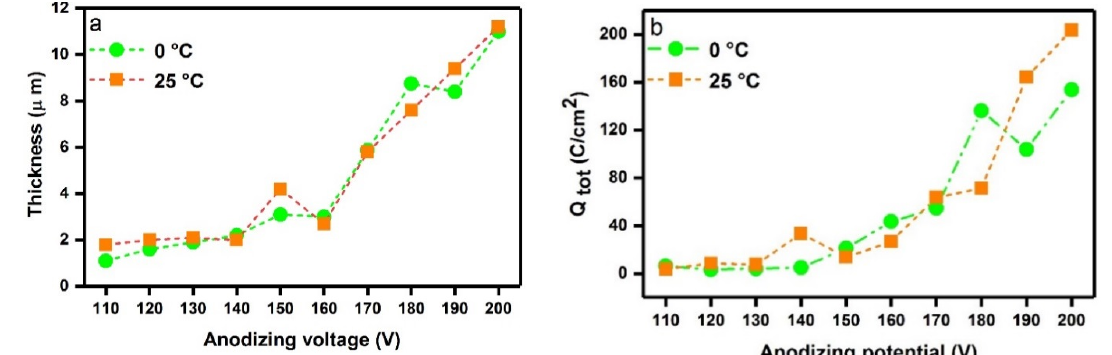
Figure 1. Thicknesses of TiO 2 films ( a ) and total charge passed during film growth ( b ) as a function of PEO potential at 0 and 25 °C.